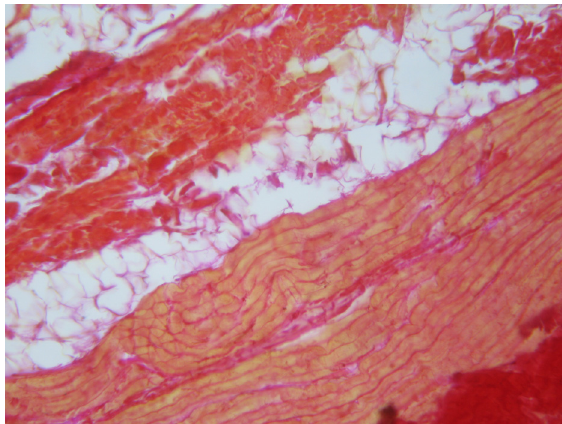
Figure 7. Microstructure of a lip tissue sample after processing with the ferment preparation Protepsin, magn. 400 (after 2.5 hours).